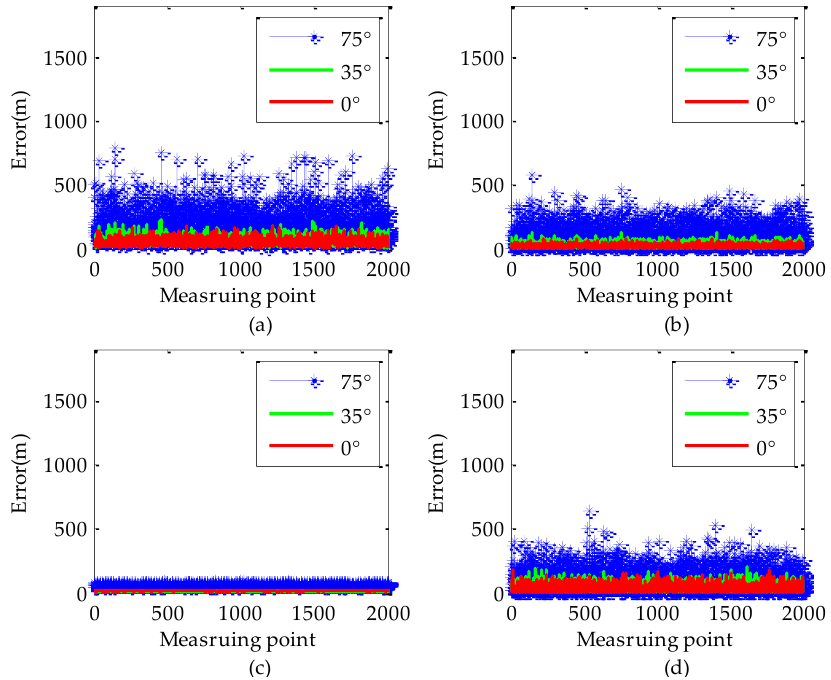
Figure 3. Geo-location error of the target by the traditional method: ( a ) Geo-location error of the target; ( b ) UAV position error in the geo-location; ( c ) LOS vector direction error in the geo-location; ( d ) Target elevation error in the